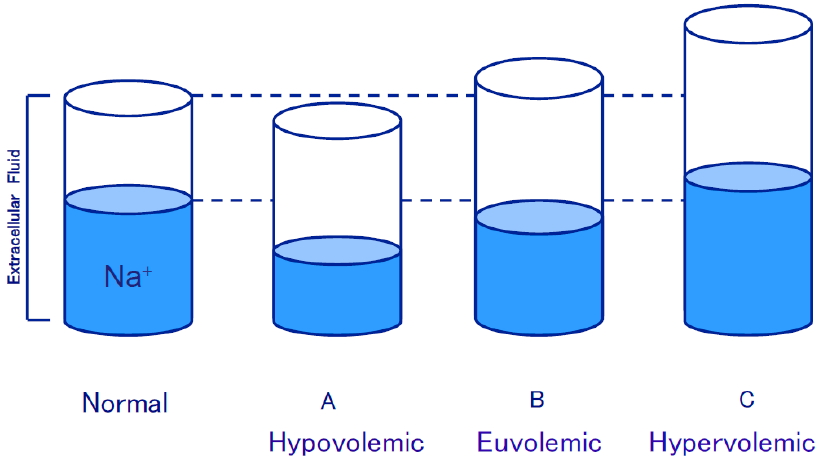
Figure 1. Three types of hyponatremia. ( A ) Hypovolemic hyponatremia; ( B ) Euvolemic hyponatremia; ( C ) Hypervolemic hyponatremia. Table 1. Causes of SIADH.